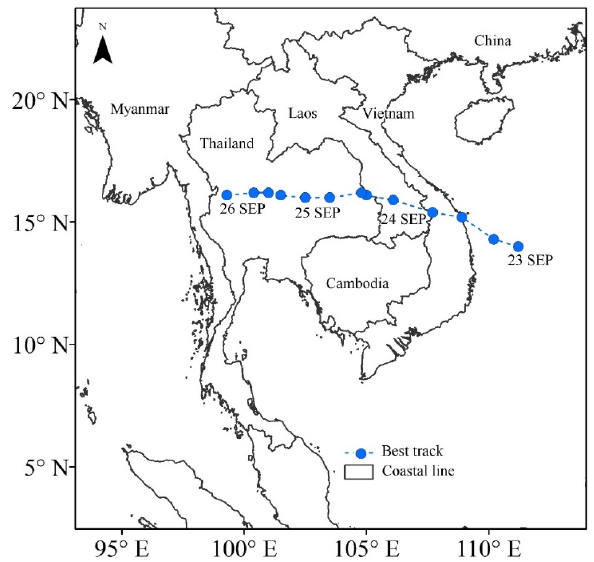
Figure 1. Observed tracking data from JMA during 00 UTC on 23 September to 00 UTC on 26 September 2021 for Tropical Storm Dianmu.